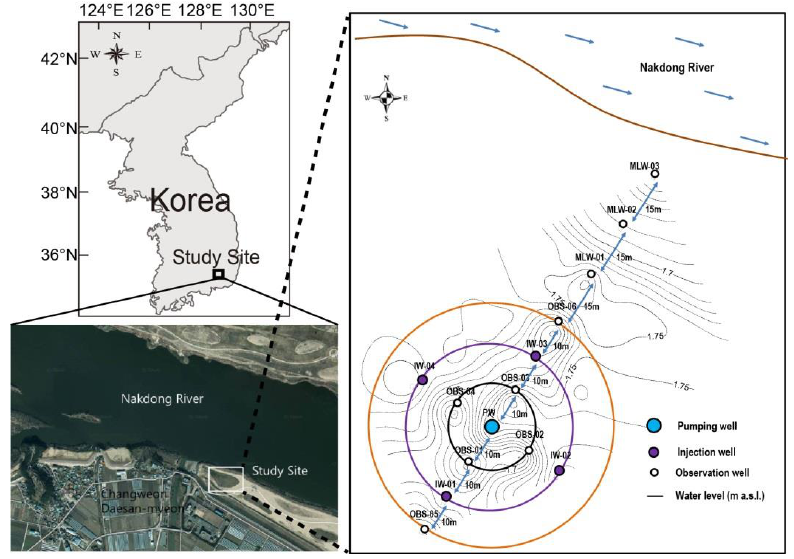
Figure 1. Map of the study site in Daesan-myeon, Changweon.